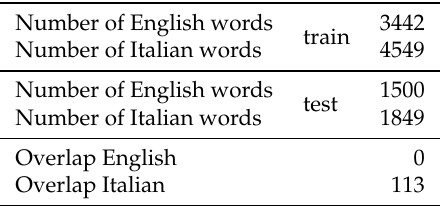
Table 3. Statistics of the original train and test split of Dinu’s data.